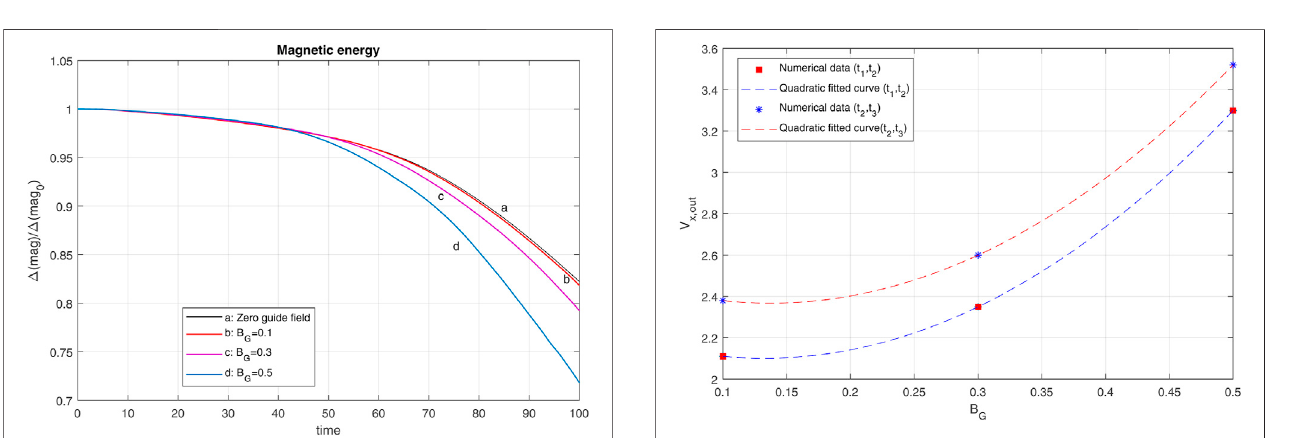
FIGURE 9 | Scaling of out fl ow velocity with uniform guide fi eld.